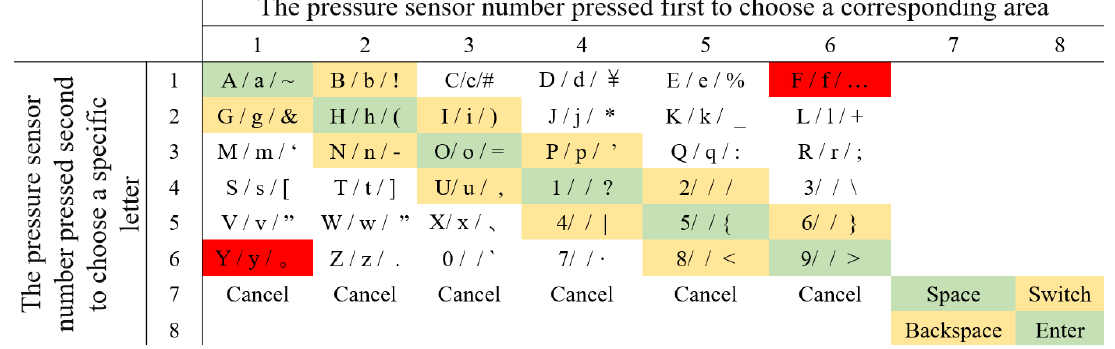
Figure 5. The corresponding serial number of inputting